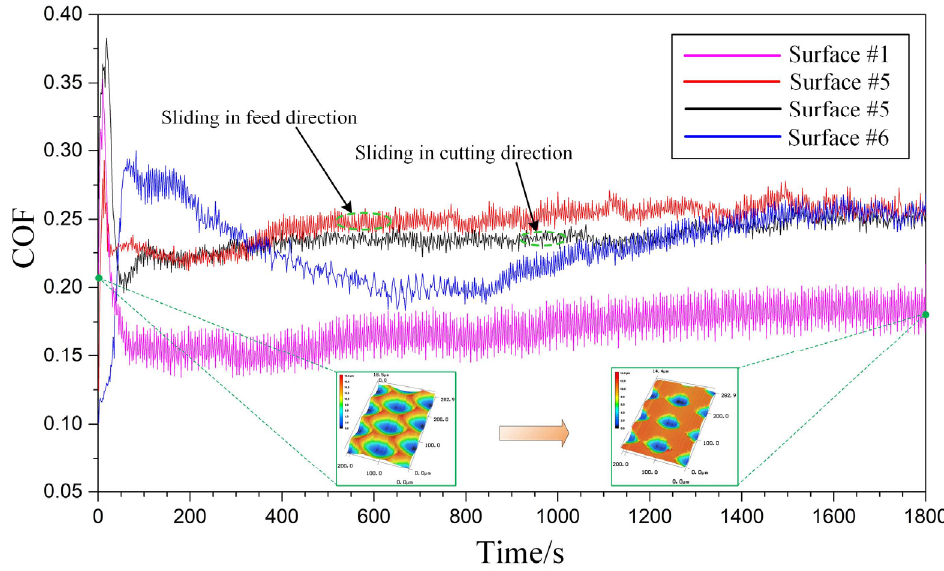
Figure 10. Variation curves of COF corresponding to different surfaces.